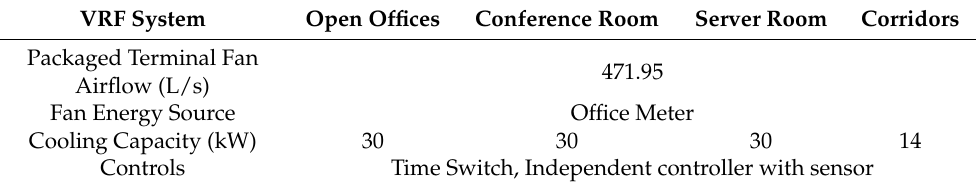
Table 11. Design variables for the Variable Refrigerant Flow (VRF) system.